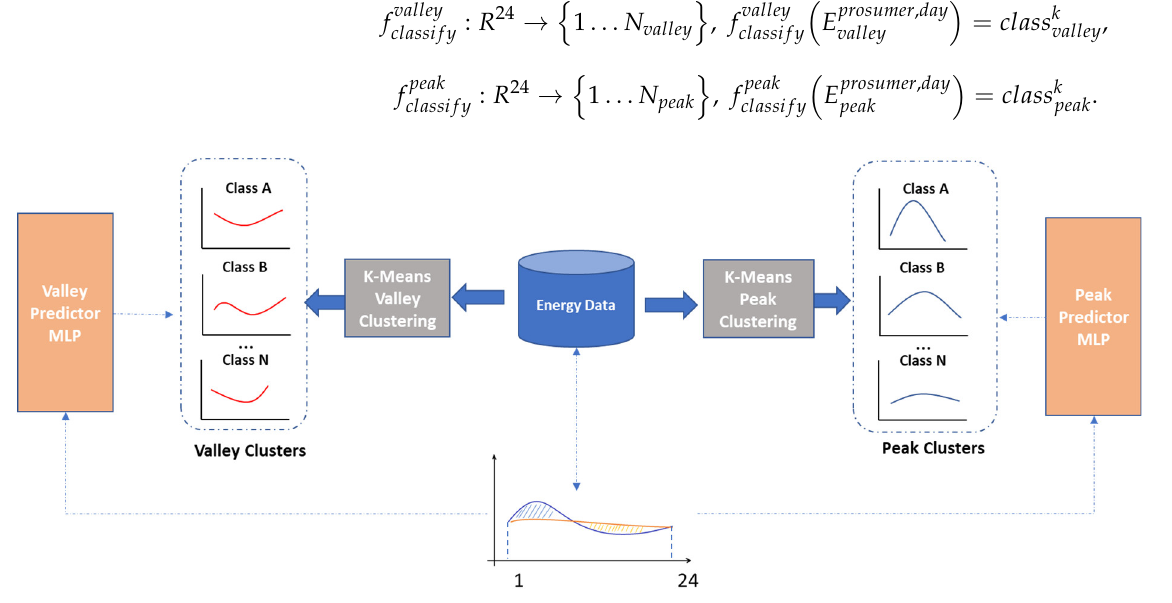
Figure 3. Clustering of peaks and valleys profiles.